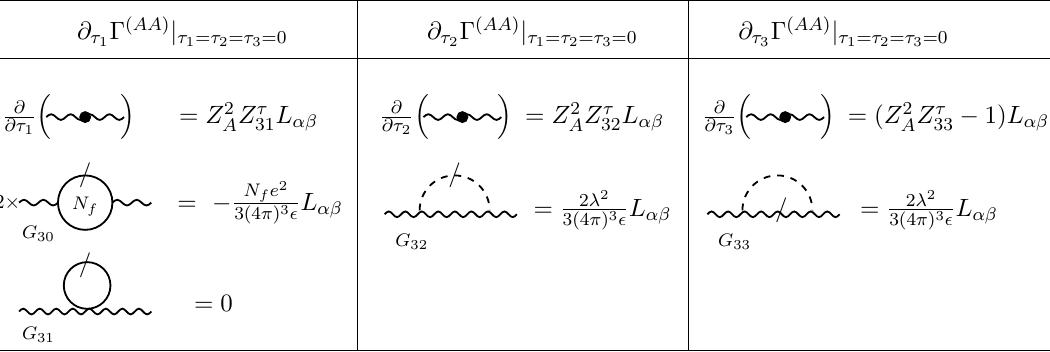
Table 5 . 2-point Green function (cid:0) ( (cid:27)(cid:27) ) di(cid:11)erentiated w.r.t. masses.